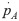
Schematic representation of the standard DEB model [18].Arrows represent energy fluxes (J d-1) that drive the dynamics of the four state variables (boxes). Energy enters the organism as food (X), is assimilated at a rate of p˙A into reserves (E). The mobilization rate (p˙C), regulates the energy leaving the reserve to cover somatic maintenance (p˙M), structural growth (p˙G), maturity maintenance (p˙J), maturation (p˙R) (immature individuals) and reproduction (p˙R) (mature individuals). κ is the proportion of the mobilized energy diverted to p˙M and p˙G, while the rest is used for p˙J and p˙R.